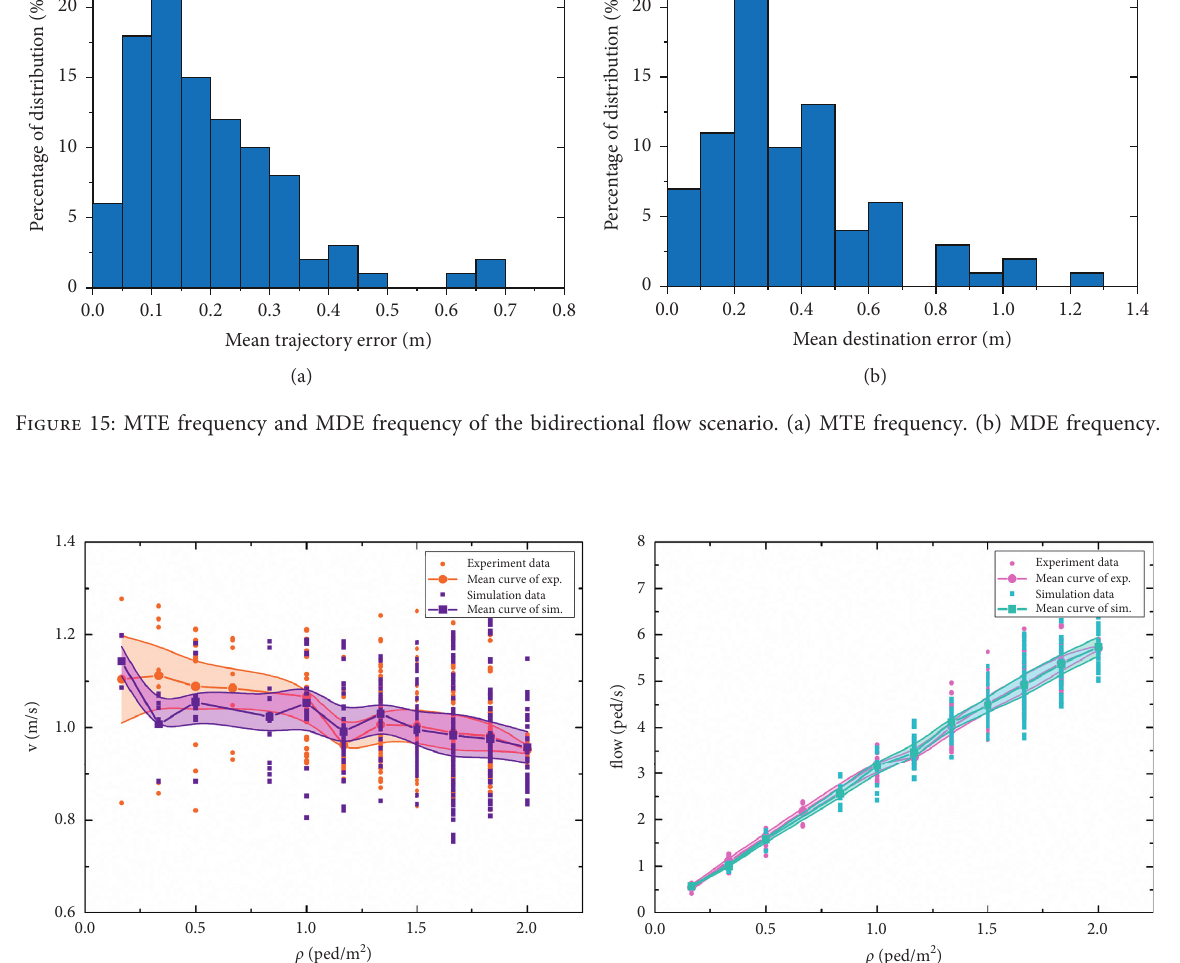
Figure 16: Comparison on density-velocity and density-flow relationships between simulated results and empirical data in the bidirectional flow scenario. (a) Density-velocity relationship. (b) Density-flow